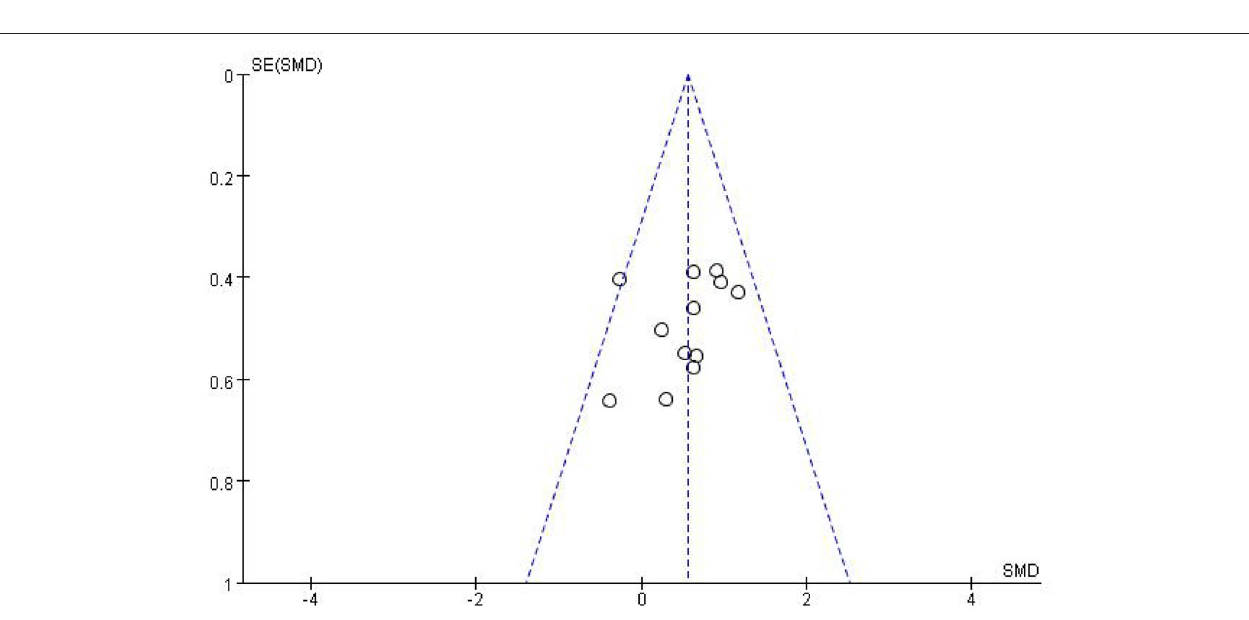
FIGURE 6 | Comparison of the effects of BCI interventions and control interventions on upper limb dysfunction before sensitivity analysis and after sensitivity analysis.